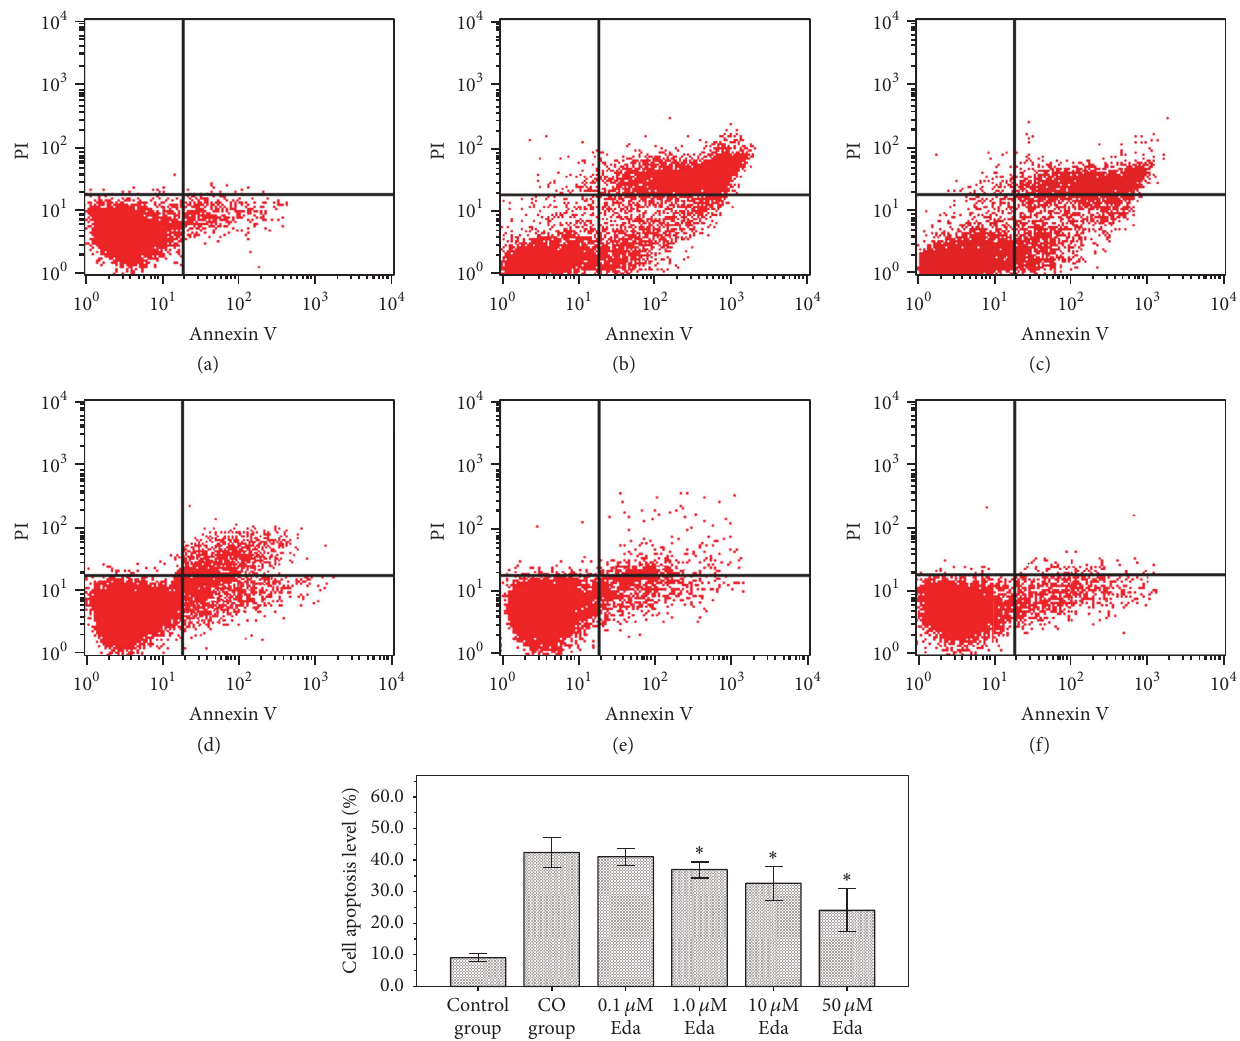
Figure 2: The results of apoptotic analysis. Cell apoptosis level of each group was detected by FCM. (a) Control group, (b) CO group, (c) 0.1 𝜇 M Eda group, (d) 1.0 𝜇 M Eda group, (e) 10 𝜇 M Eda group, and (f) 50 𝜇 M Eda group. Compared with CO group: ∗ 𝑃 < 0.01 .